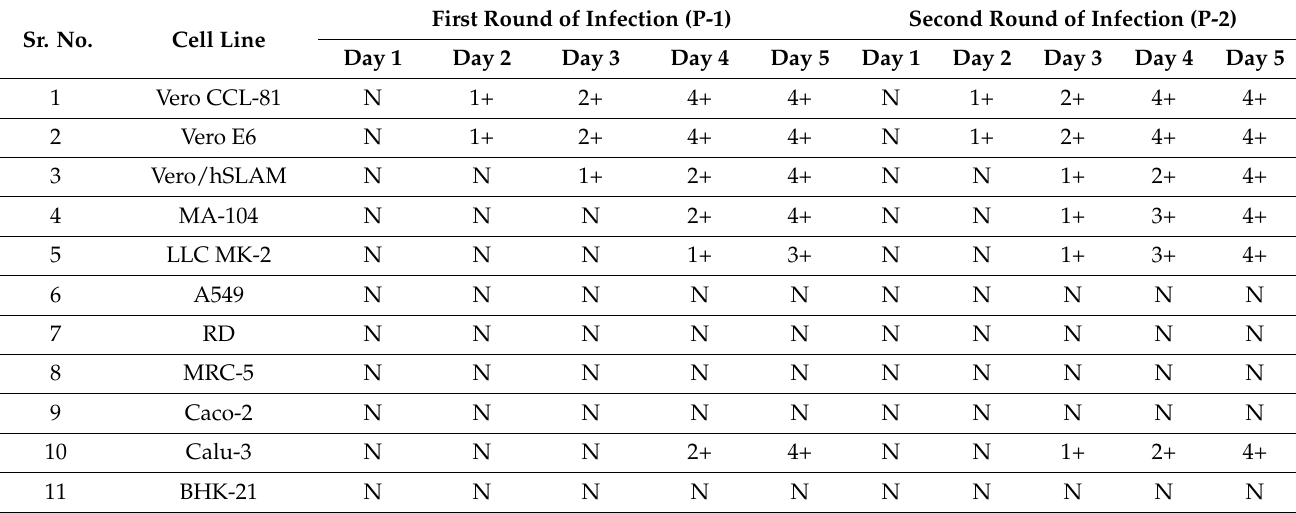
Table 2. Differential cell line susceptibility to Omicron BA.1.1 variant as defined by cytopathic effect (CPE) on days 1 to 5 after infection with SARS-CoV-2 Omicron BA.1.1. Sr. No.